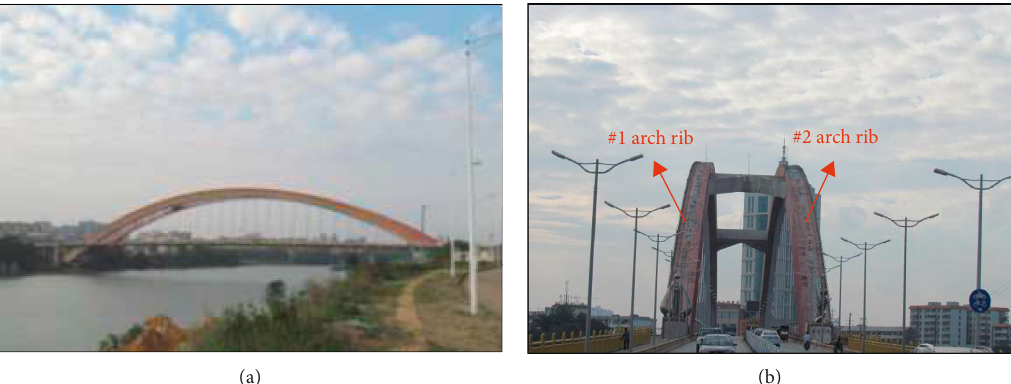
Figure 4: Photos of the bridge under